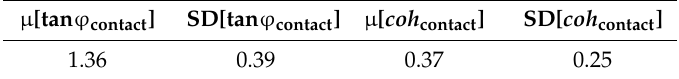
Table 4. Parameters of normal distributions for average friction coefficient and average cohesion.